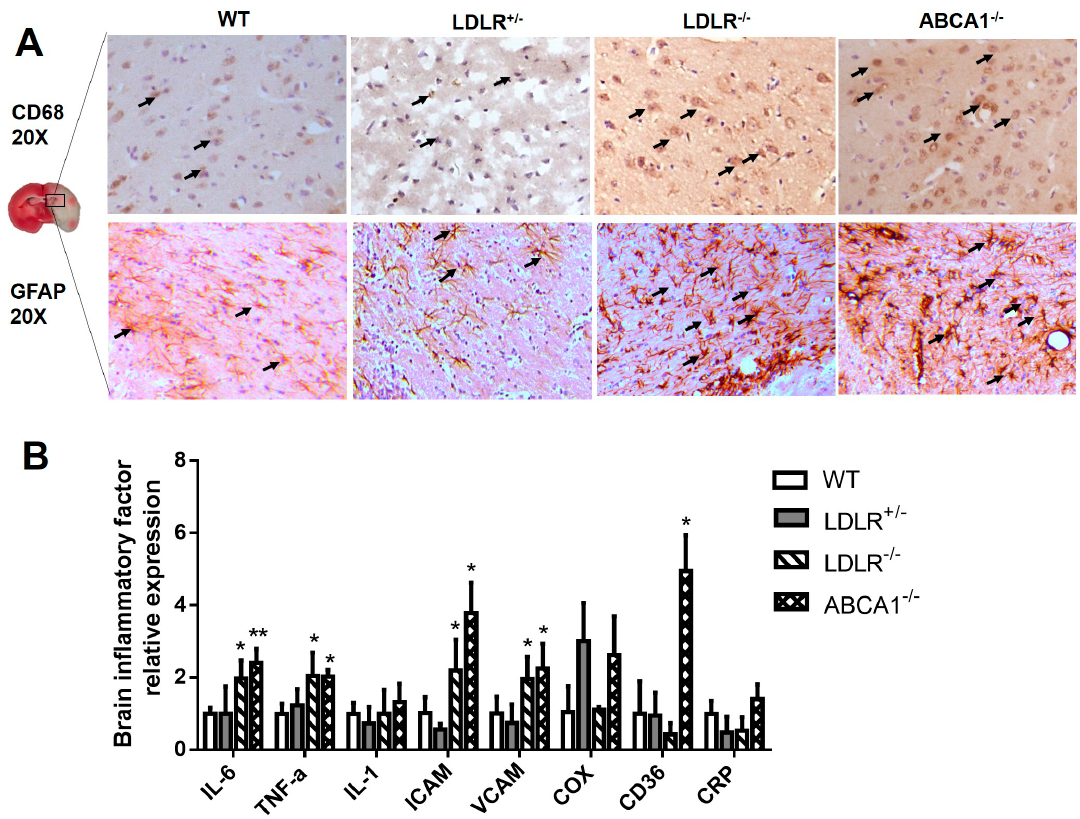
Figure 5. E ff ect of high LDL-C and low HDL-C on brain inflammation in hamsters with IS. ( A ) Representative images of immunostaining of CD68 and GFAP in ischemic cerebral areas of di ff erent genotypes. The arrows indicate positive staining. ( B ) The brain mRNA expression of inflammatory biomarkers in di ff erent hamster genotypes ( n = 8 / group). Data are expressed as mean ± SD. * p < 0.05; ** p < 0.01 versus WT group.